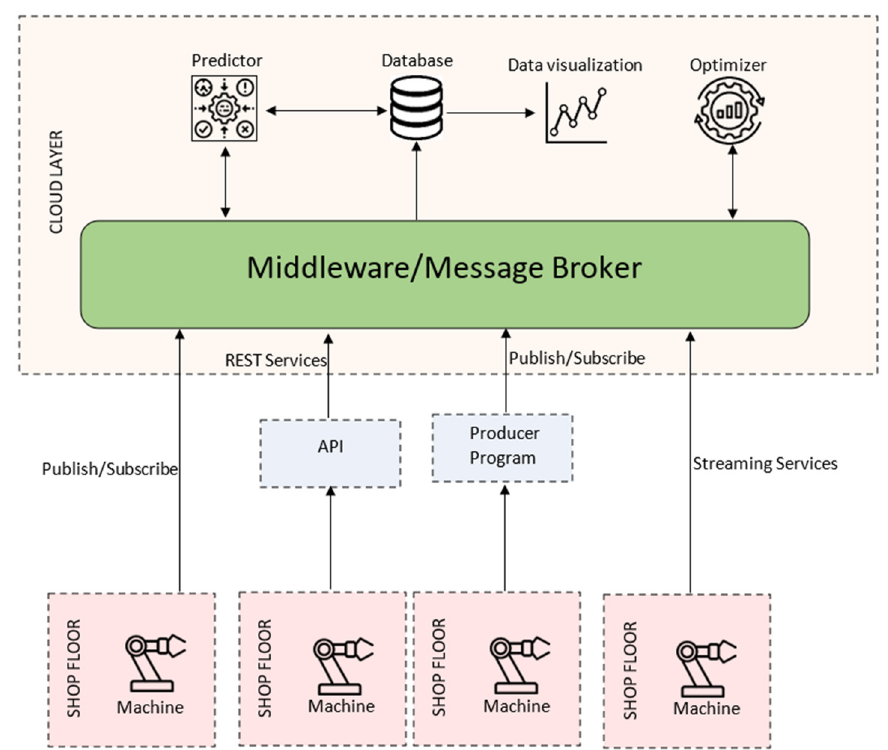
Figure 1. System